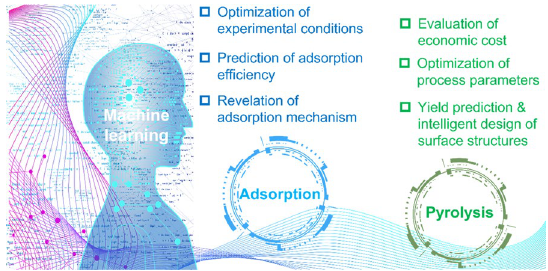
Fig. 3 Application of machine learning in optimizing pyrolysis process and modeling adsorption process of biochar for pollutant